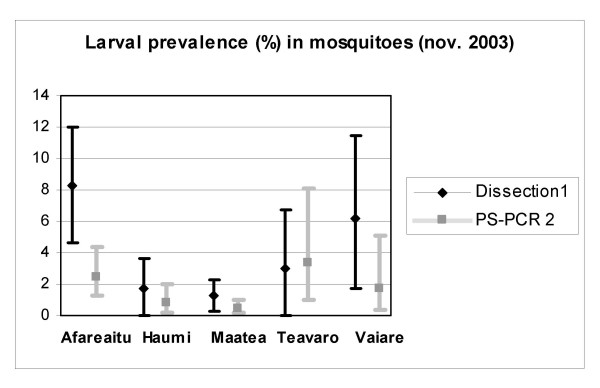
W. bancrofti (L1–L3) prevalence in dissected and PCR-poolscreened mosquitoes collected in november 2003. 1 prevalence [95% confidence interval] 2 point estimate [95% confidence interval]